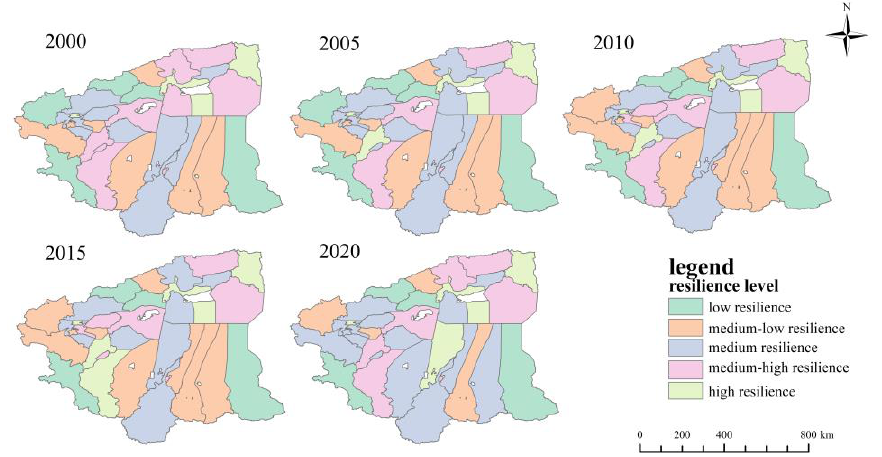
to Figure 7. Distribution of density resilience level in four prefectures of southern Xinjiang from 2000 to 2020.